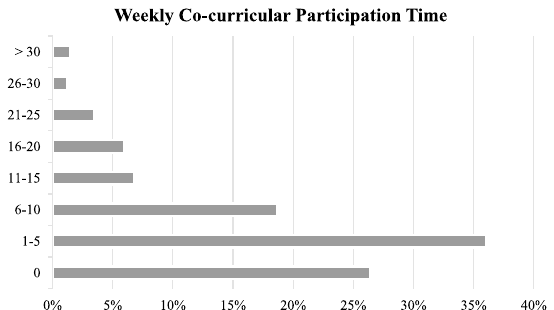
Fig. 1 Time spent on co-curriculars as reported by students in the 2017 NSSE ( N =